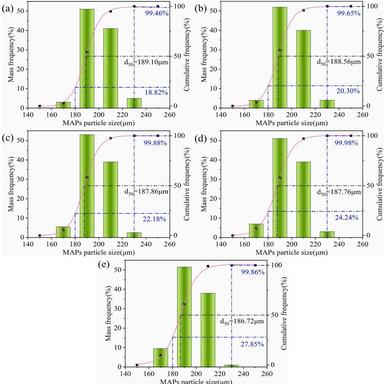
The effect of cBN powder flow rates on the particle size distribution of cBN-MAPs: (a)60 g/min; (b)120 g/min; (c)180 g/min; (d)240 g/min; (e)300 g/min.